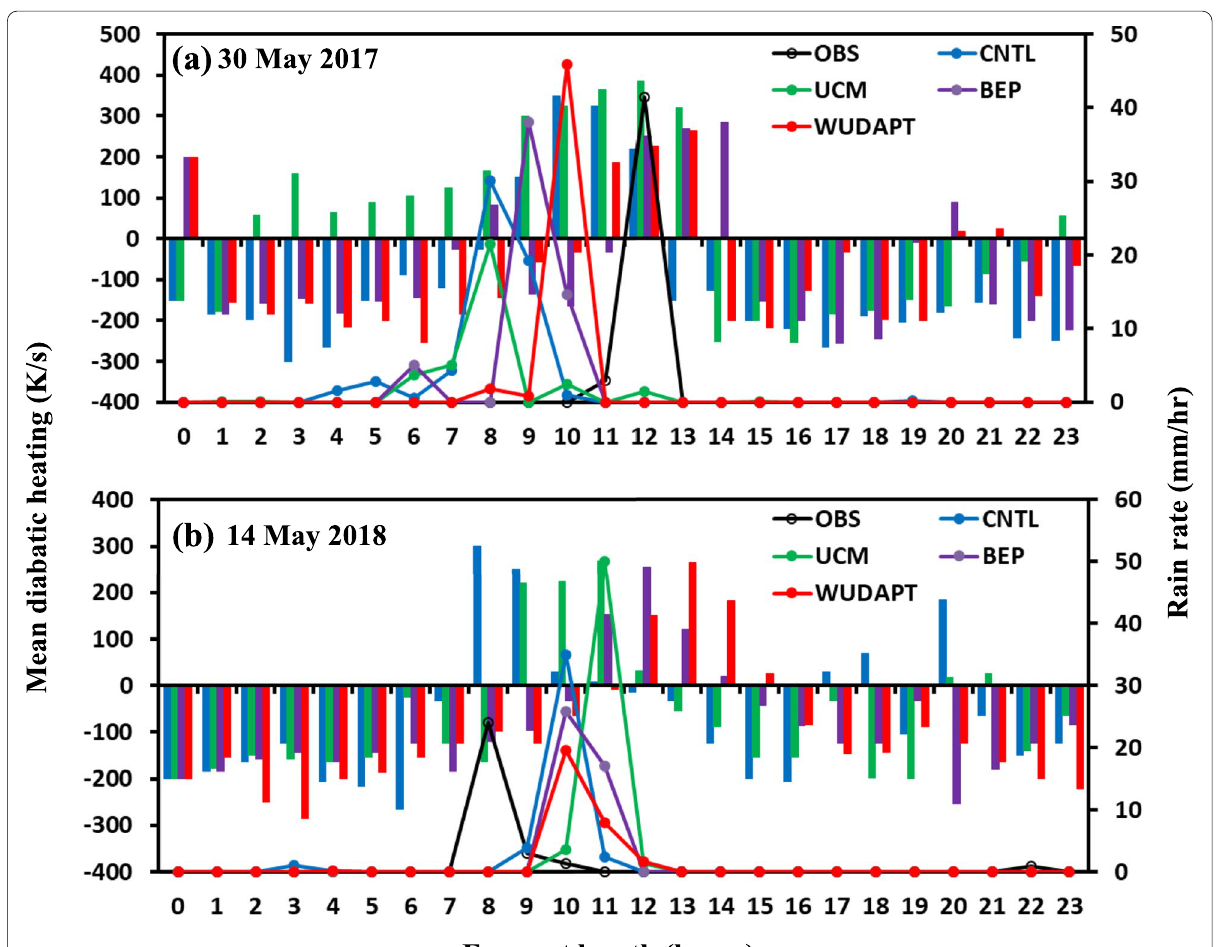
Fig. 7 Area Averaged diabatic heating (K/s) from all the experiments for 30 May 2017 case along with simulated and observed Rain rate. The histograms (lines) represents the diabatic heating (rainrate). Same color code will be applied for diabatic heating